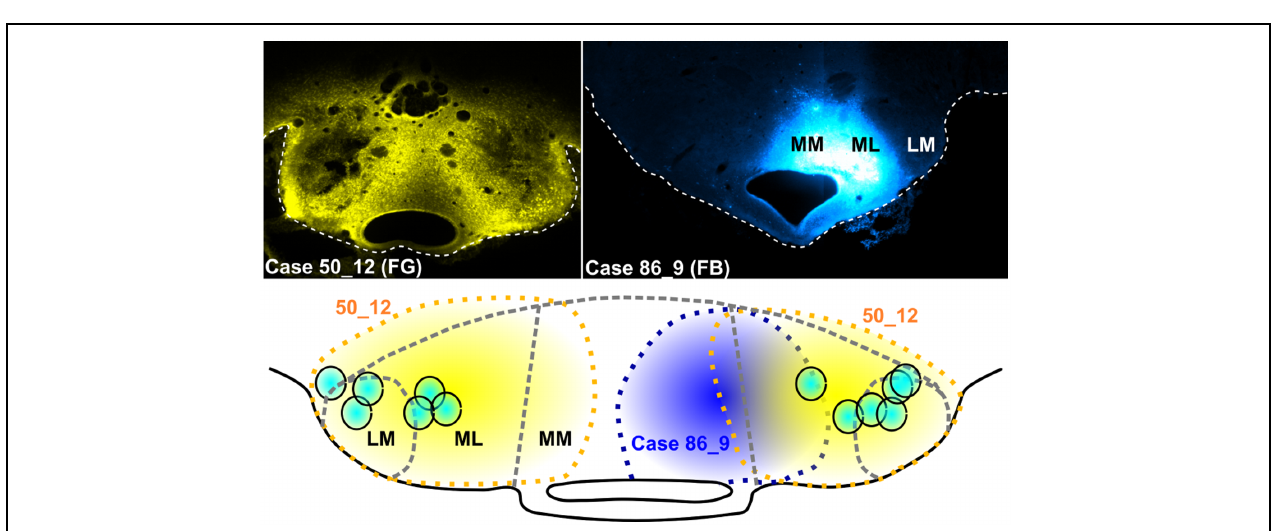
FIGURE 4 | Mammillary body injection sites: Photomicrographs of two representative cases, one with bilateral Fluorogold (FG) injections (upper left; case 50_12) and the other, a unilateral injection of Fast Blue (FB) localized to the right medial mammillary body nucleus (upper right;